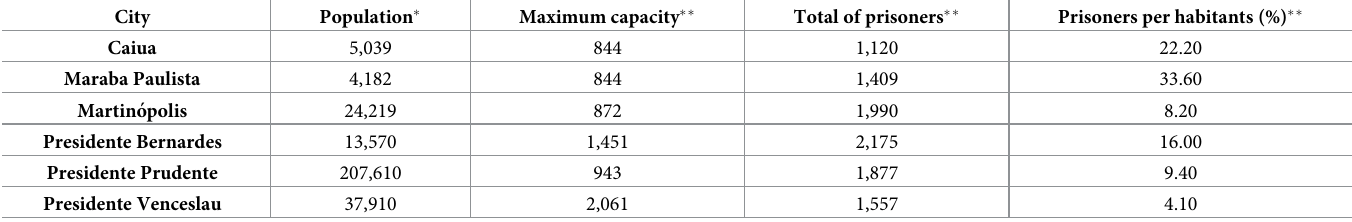
Table 2. Population in male prison units located in the Pontal do Paranapanema region. All prisons showed number of prisoners higher than its maximum capacity, excepted Presidente Bernardes city. Range of prisoners per habitants variated from 4.10 to 33.60. Databases: � Brazilian Institute of Geography and Statistics—IBGE (2010); �� Department of Penitentiary Administration—SAP